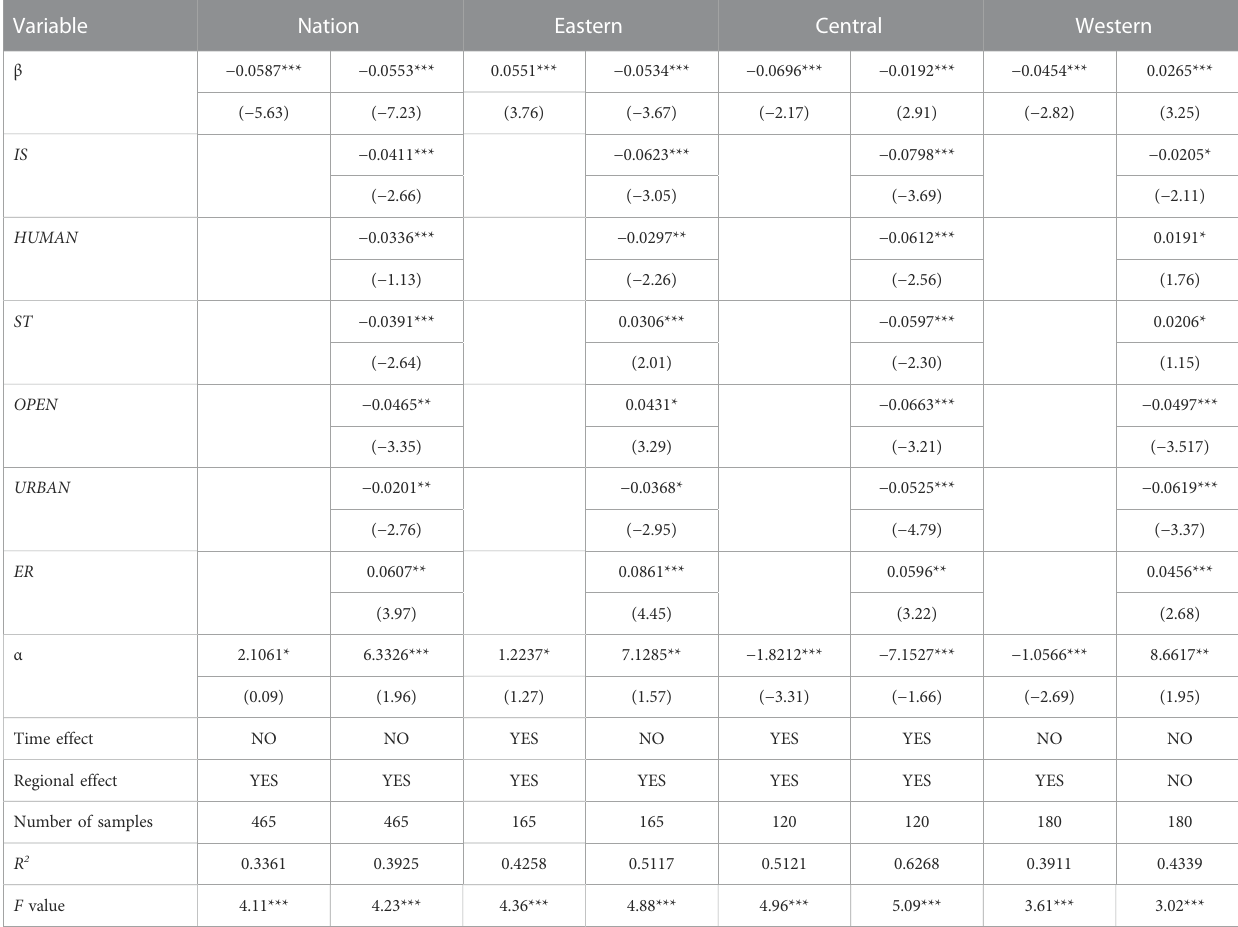
TABLE 4 Test results of absolute β convergence and conditional β convergence.